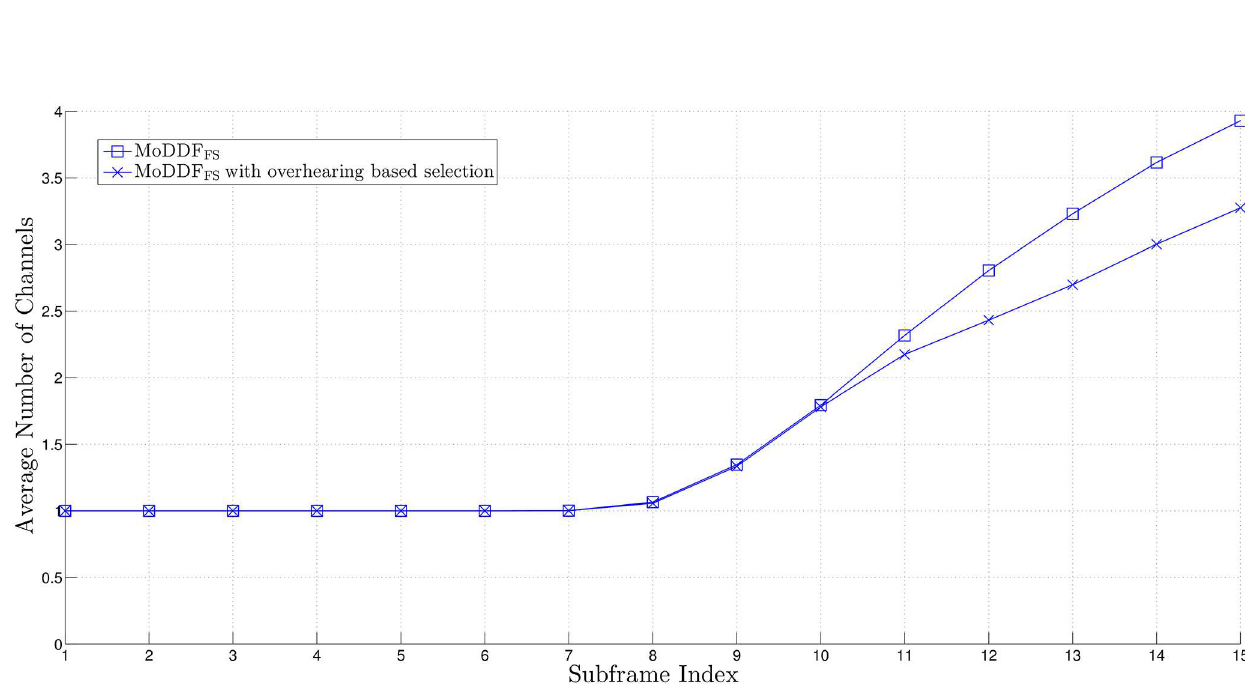
¼ 2 dB, R th = 20, and γ T = 20 dB. SD